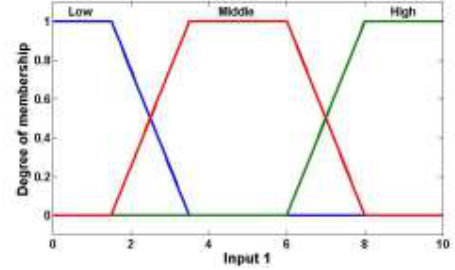
Figure 2. Membership functions of the Input 1